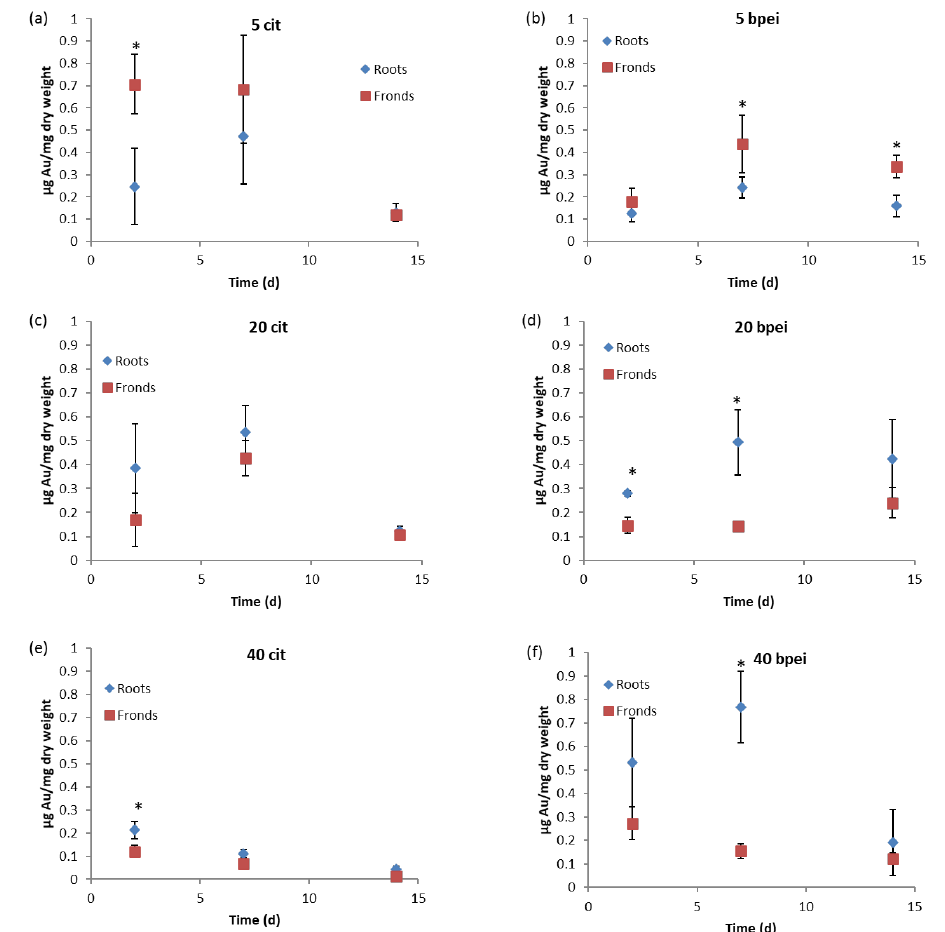
Figure 4. Gold concentrations ( µ g/mg dry weight) on S. minima exposed to 10% Hoagland’s medium at 1000 µ g/L, ( a ) 5 nm Cit-nAu, ( b ) 20 nm Cit-nAu, ( c ) 40 nm Cit-nAu, ( d ) 5 nm BPEI-nAu, ( e ) 20 nm BPEI-nAu, and ( f ) 40 nm BPEI-nAu. Results are presented as mean ( n = 3), bars denote standard deviations (SD), and * denotes significant differences between roots and fronds per time period using Two-way ANOVA at p < 0.05.